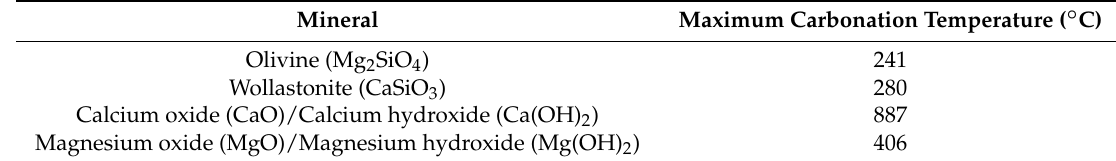
Table 7. Maximum carbonation temperature for several minerals at CO 2 partial pressure of 1 bar